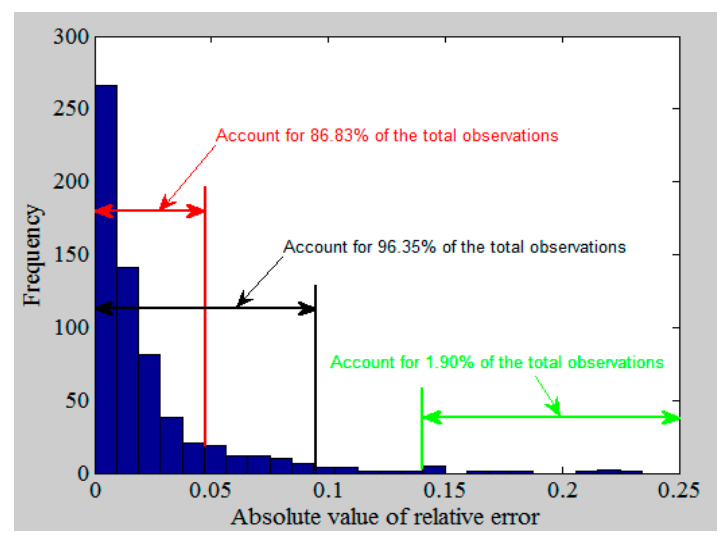
Figure 2. Distribution of relative errors of the province’s contribution rate.